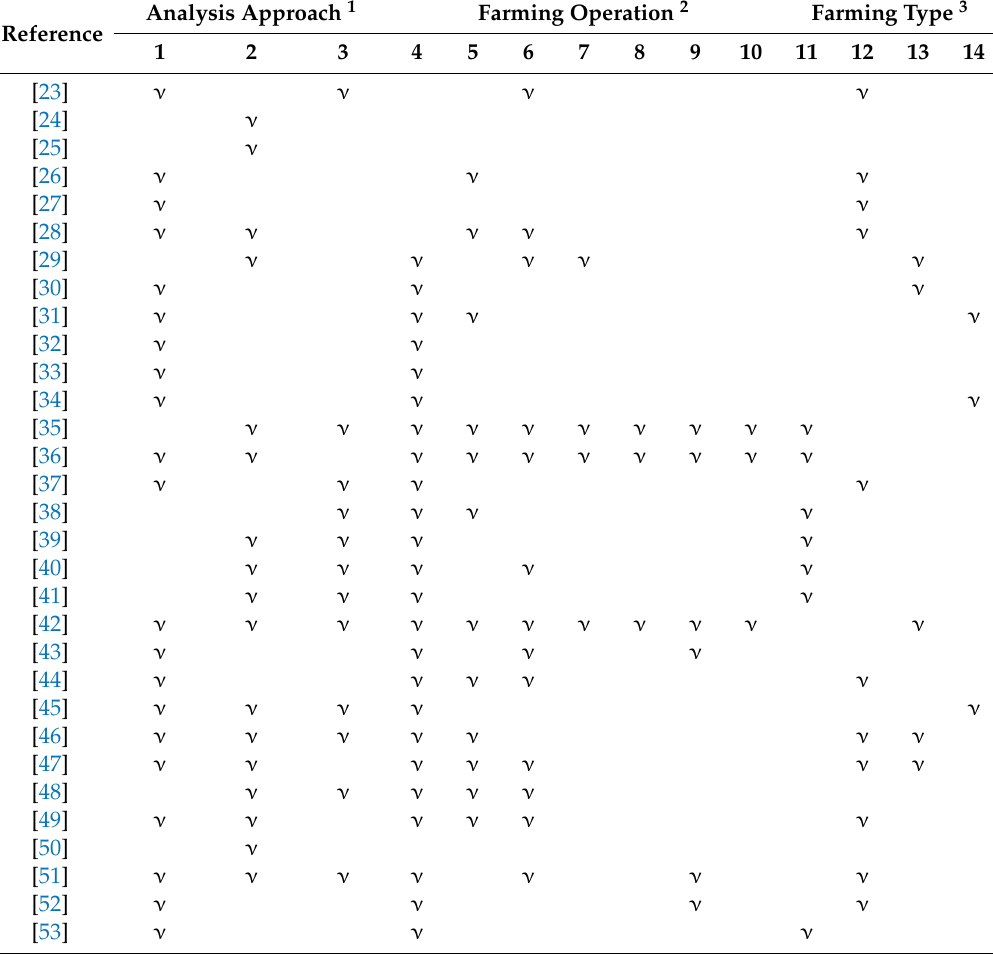
Table 1. Critical taxonomy of research studies assessing agricultural robotic